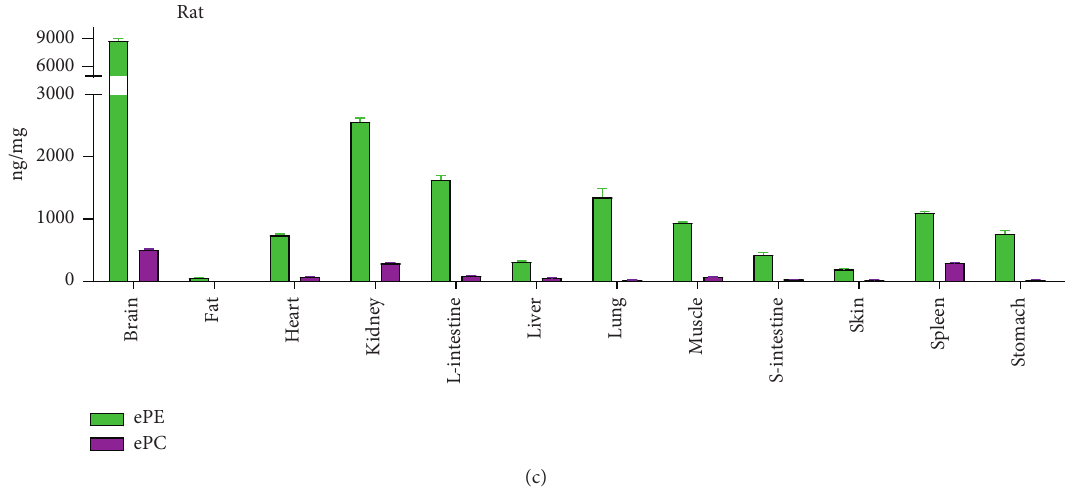
Figure 5: Absolute amounts of ether lipids as quantified in 12 organs/tissues from CD1 and NMRI mice and rats ( n �